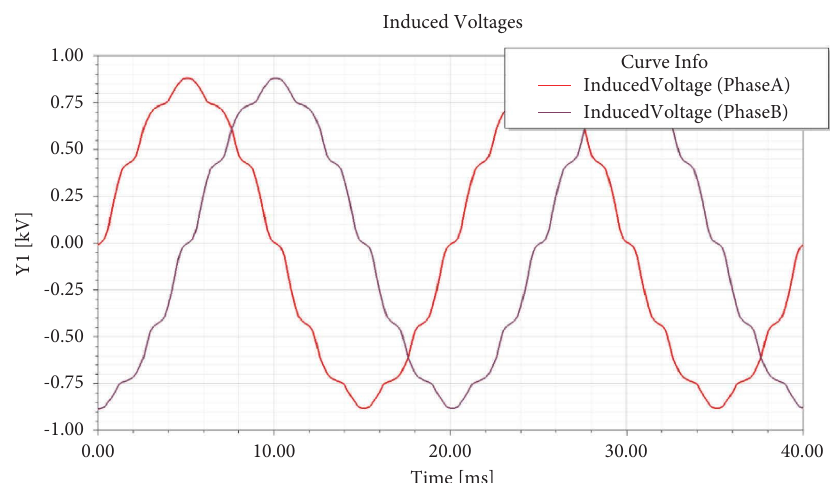
Figure 35: Back EMF curve of fat-bottom circular slot